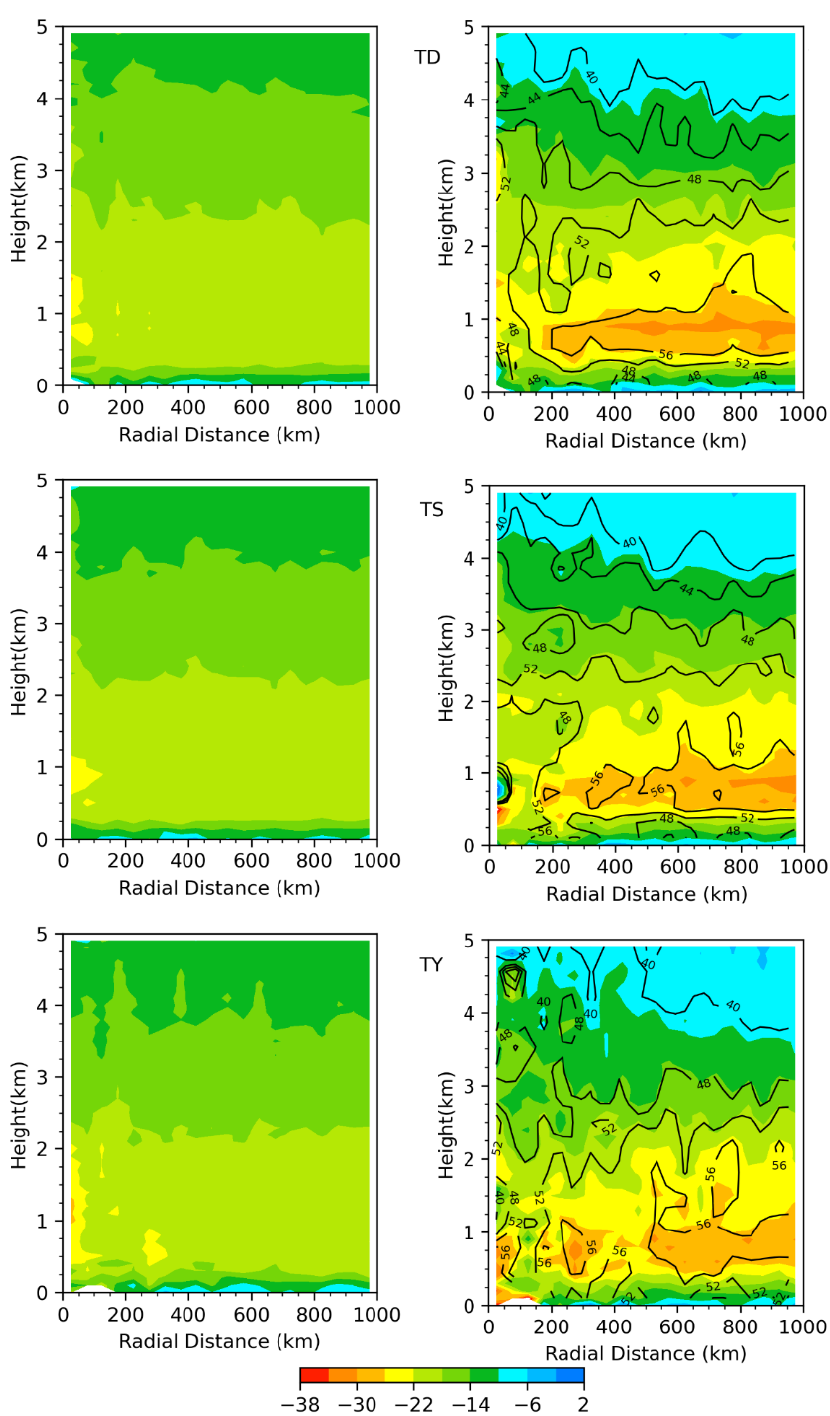
Figure 9. Composite N idry ( left ; colored shading) and N iwet ( right ; colored shading) vertical gradients (N-unit km − 1 ) cross sections and N iwet mean vertical gradients as a percentage of N i mean vertical gradients ( right ; contour lines; %) calculated by collocated COSMIC-2 ROs data in each 50-km radial distance over the western Pacific: ( top ) TD, ( middle ) TS, and ( bottom ) TY.